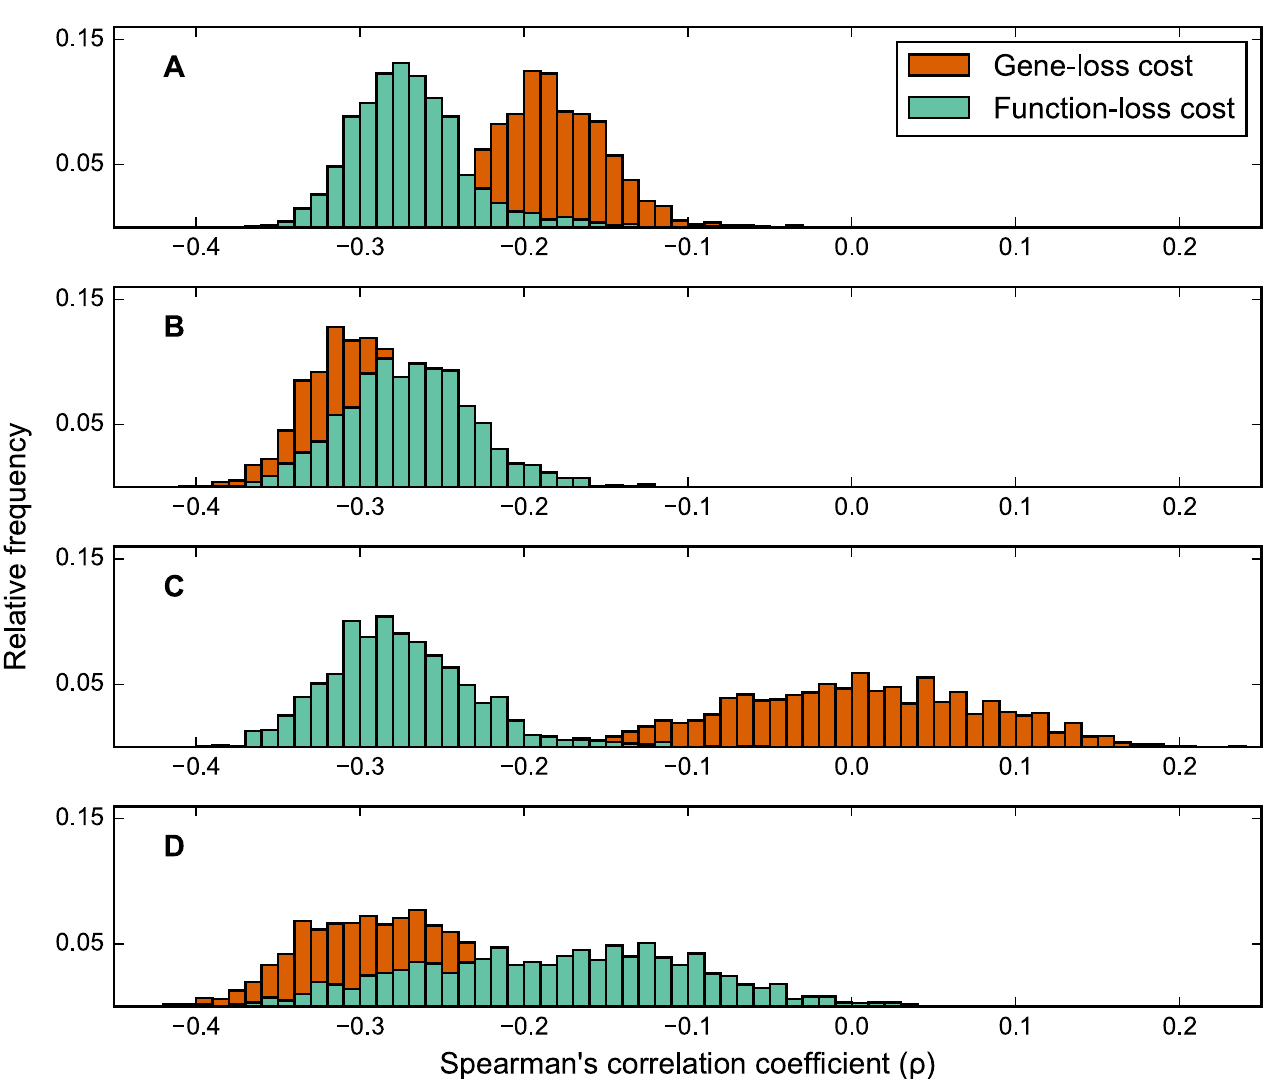
Fig 2. Frequency distributions of (Spearman’s rank) correlation between gene evolutionary rate and gene deletion impact scores. Frequencydistributionsof gene dispensability and evolutionary rate correlations. Gene evolutionaryrate was calculatedper gene as the average ranked d N / d S ( K a / K s ) ratio betweenthe S . cerevisiae gene and its orthologin five related yeast species. A gene’sdeletionimpact score was predictedwith FBA using gene-loss cost (dark orangedistributions) and function-loss cost (light green distributions). Rows show distributions for: (A) all genes, (B) all genesexcept isoenzymes, (C) isoenzymes only, and (D) only multi-functional enzymes that are not